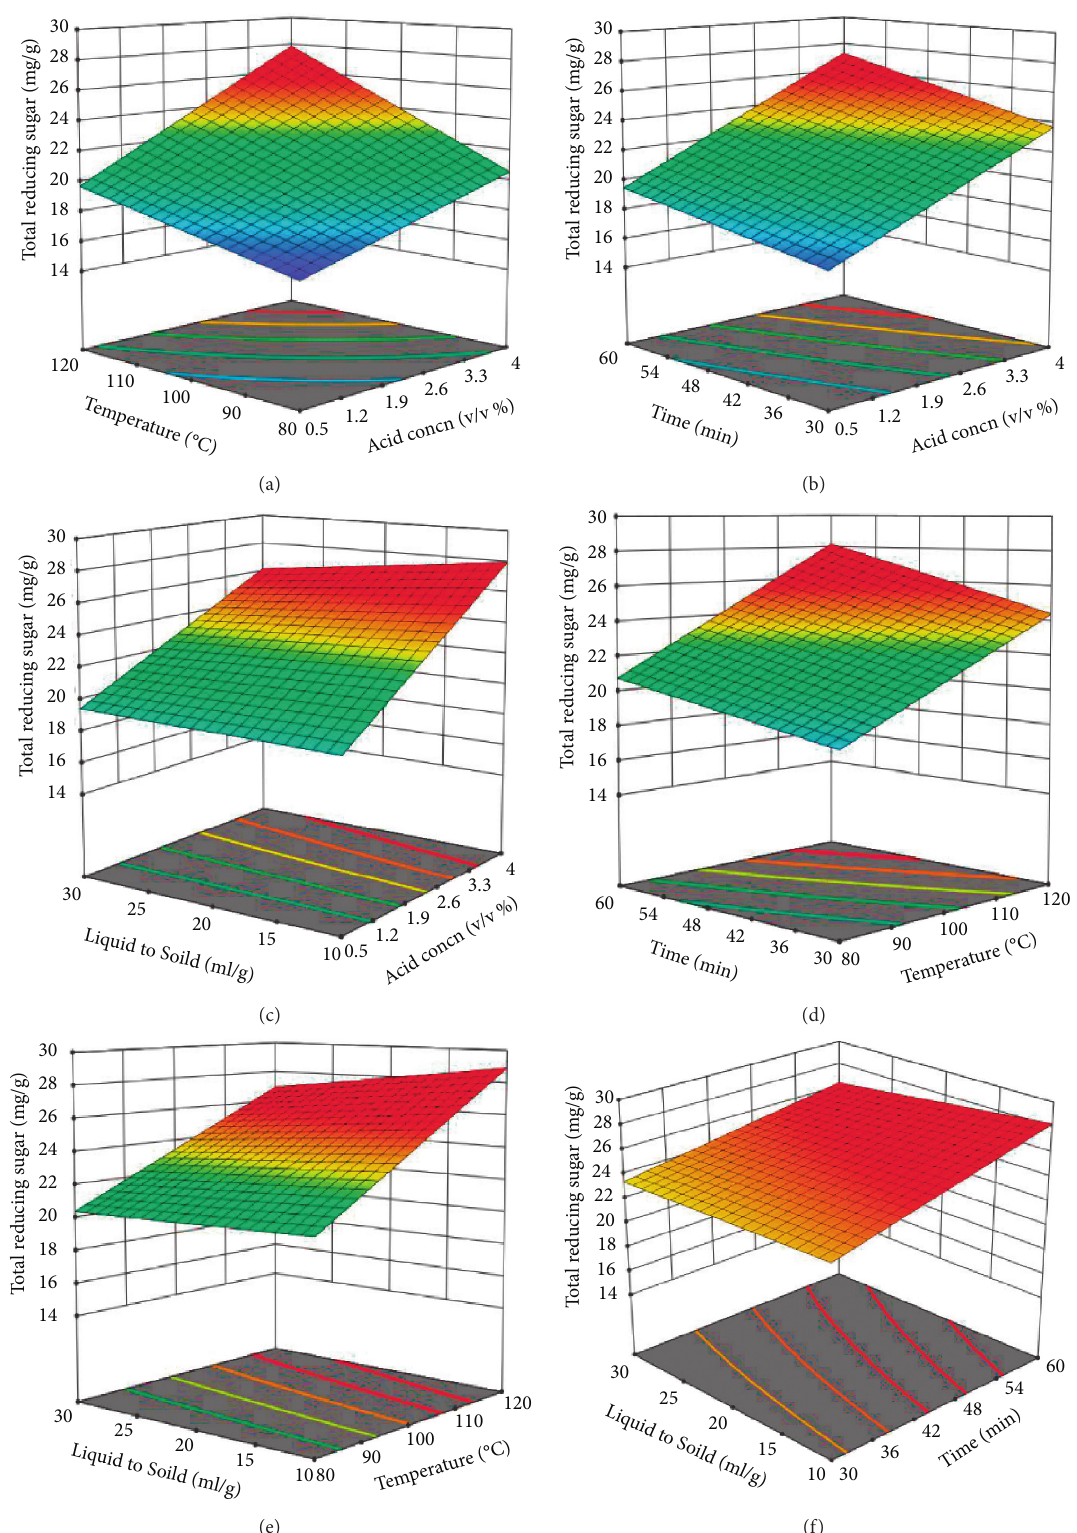
Figure 7: Surface plots showing the effect of (a) temperature and dilute sulfuric acid concentration, (b) dilute sulfuric acid concentration and hydrolysis time, (c) dilute sulfuric acid concentration and liquid to solid ratio, (d) temperature and hydrolysis time, (e) temperature and liquid to solid ratio, and (f) liquid to solid ratio and hydrolysis time on the total reducing sugar